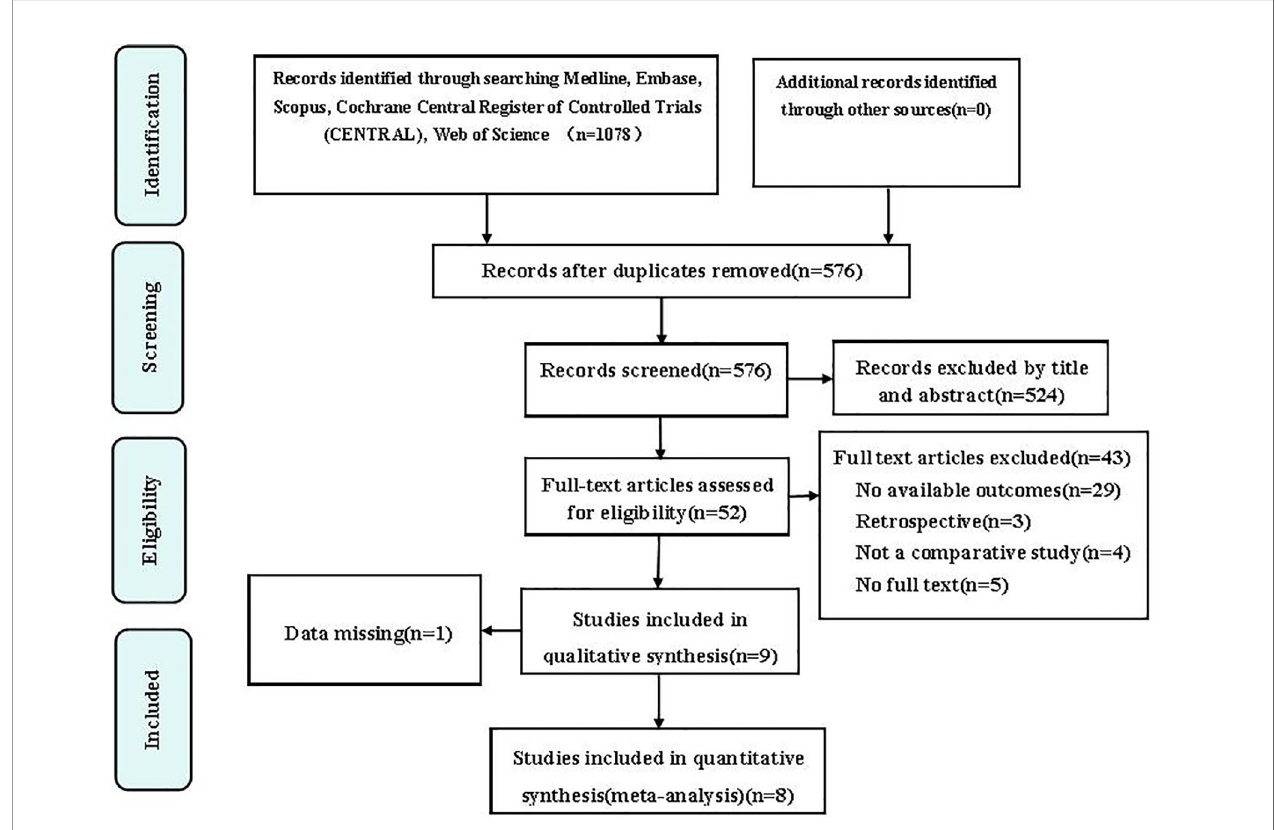
FIGURE 1 | Flow chart showing the study identi fi cation and selection